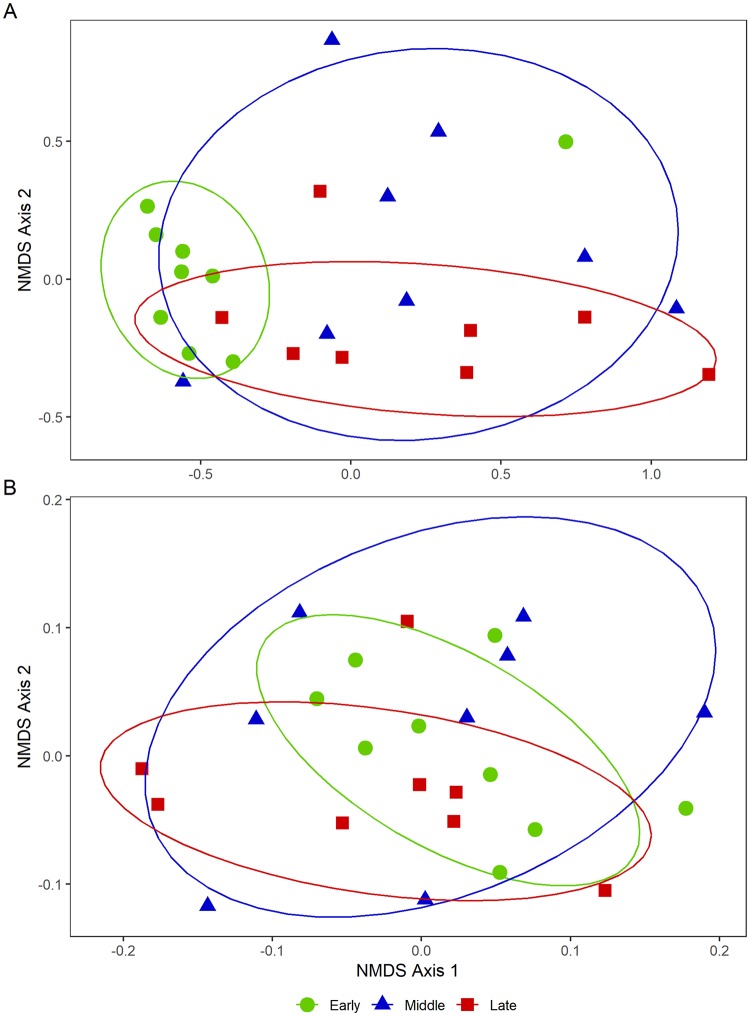
Non-metric multidimensional scaling (NMDS) plots for Japanese Black beef cattle.NMDS plots were generated for the bacterial OTUs (A) and Kyoto Encyclopedia of Genes and Genomes (KEGG) pathway categories (B). The stress of NMDS analysis was 0.10 and 0.14 for the OTU- and KEGG pathway-based ordinations, respectively.